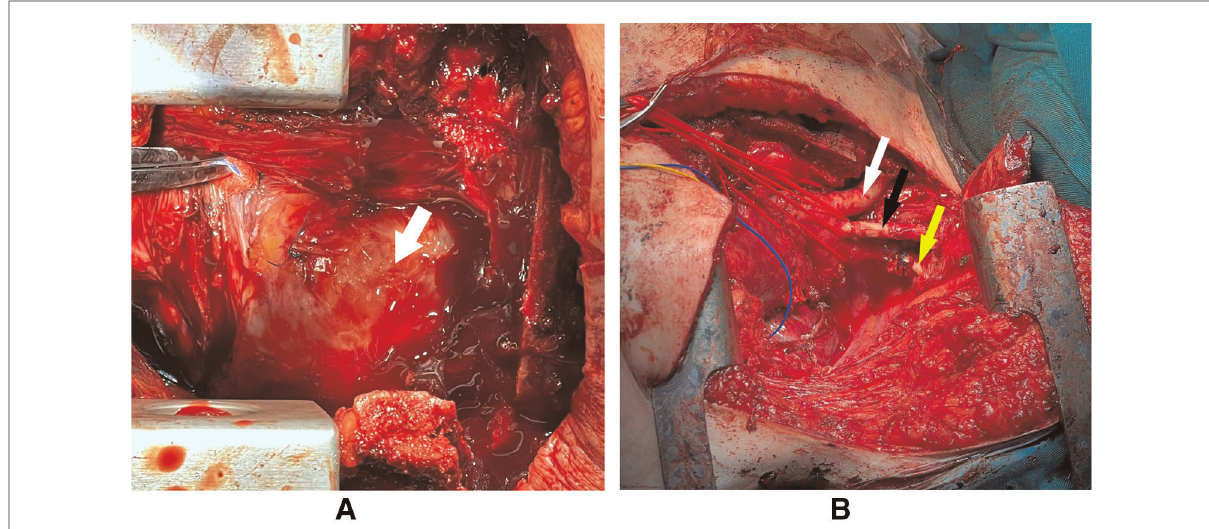
FIGURE 3 The arrow in panel ( A ) pointing at the tumor which is occupying the whole anterior mediastinum with some sutures from previous surgery. Panel ( B ) showing the arch of the aorta and its branches after the total resection of the intrathoracic tumor (white arrow: brachiocephalic artery, black arrow: left common carotid, yellow arrow: left subclavian artery).